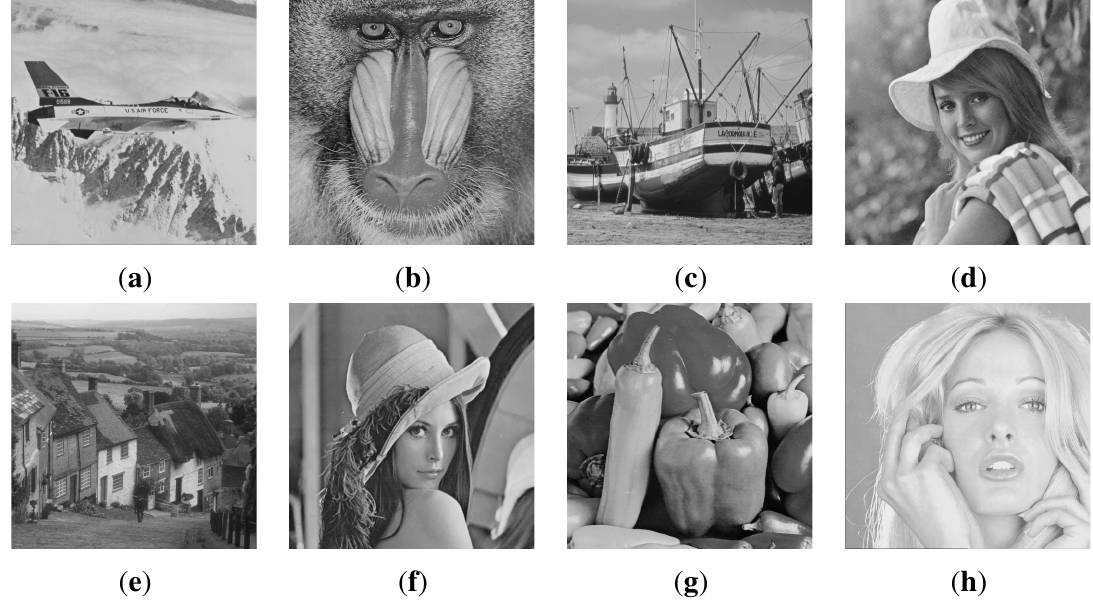
Figure 2. Eight 512 × 512 gray test images. ( a ) F16; ( b ) baboon; ( c ) boat; ( d ) Elaine; ( e ) Gold Hill; ( f ) Lena; ( g ) pepper; ( h )